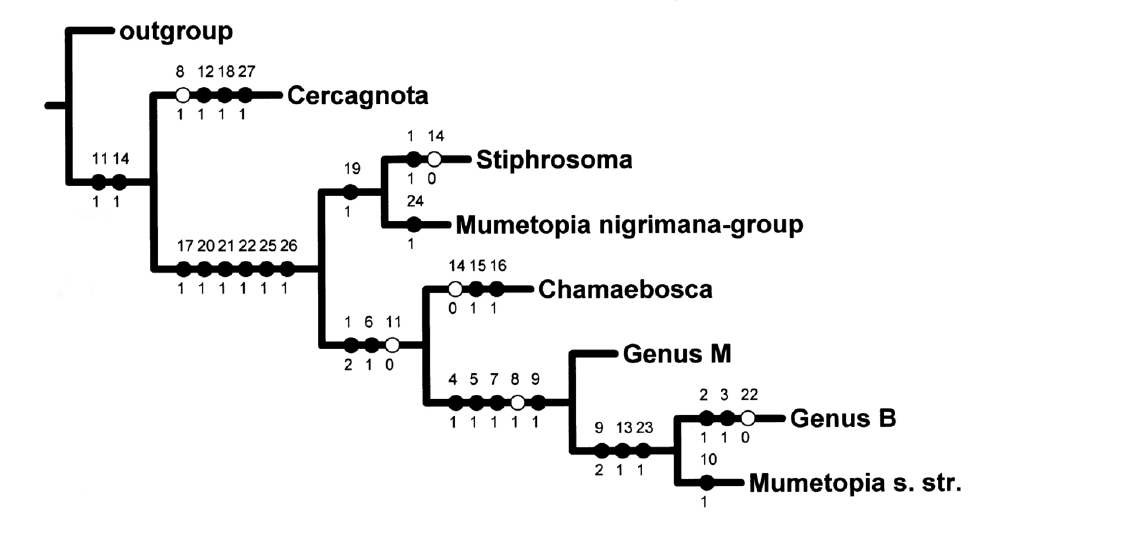
Fig. 34. Most parsimonious tree (L = 34 steps, CI = 0.85, RI = 0.82) resulting from cladistic morphological analysis of the Chamaebosca clade, ACCTRAN optimization. Full circles = non-homoplasious character transformations; empty circles = homoplasious character transformations. Numbers below branches indicate change to apomorphic (1, 2) or plesiomorphic (0) states of characters (reversals in case of (0)). Adapted from Roháček & Barber (2009: fig.